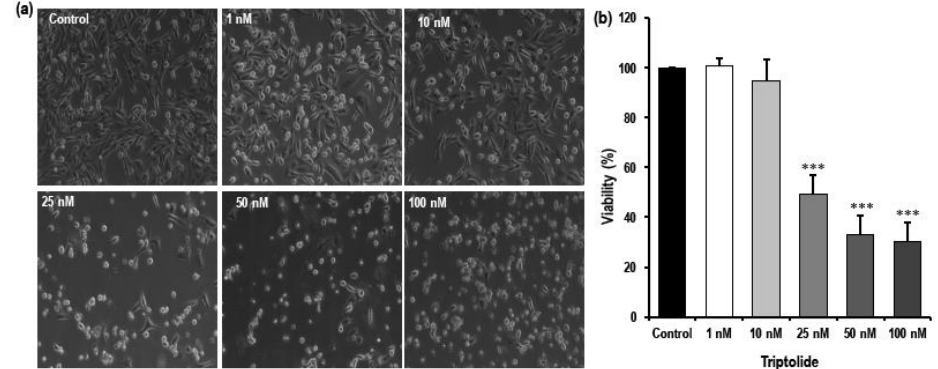
Figure 2. Cellular morphology and viability of MDA-MB-231 cells in response to triptolide treatment. ( a ) Representative phase contrast images of MDA-MB-231 under different concentrations of triptolide